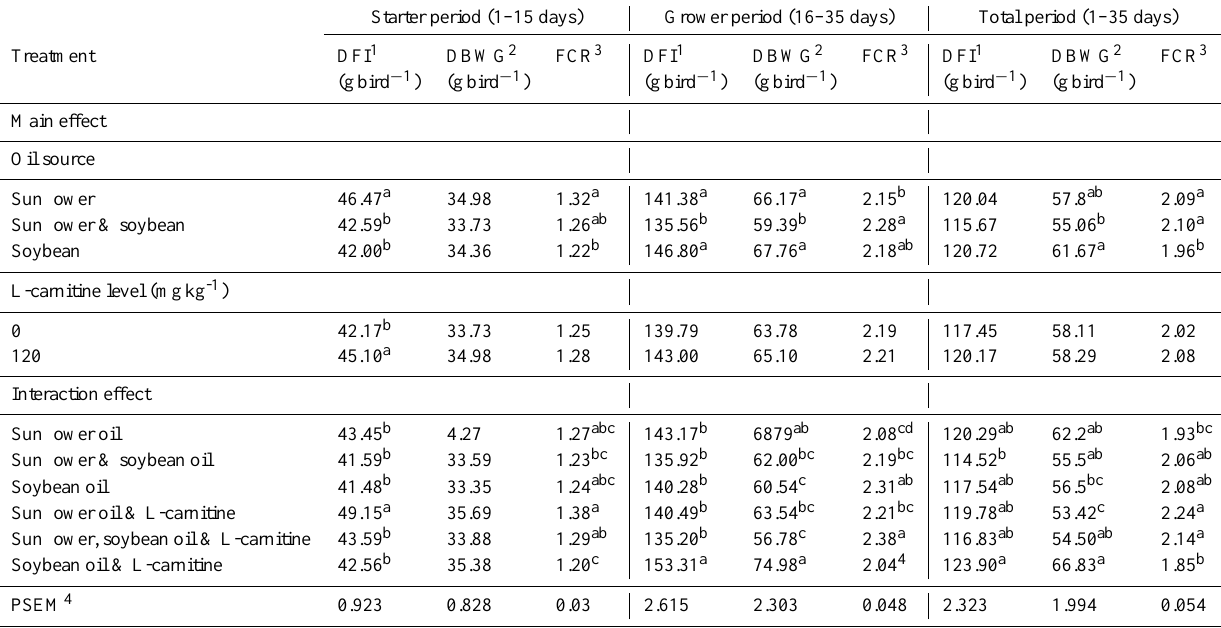
Table 3. Effects of dietary oil sources and L-carnitine supplementation on growth performance of broiler chicks in the starter, grower and total period of rearing.